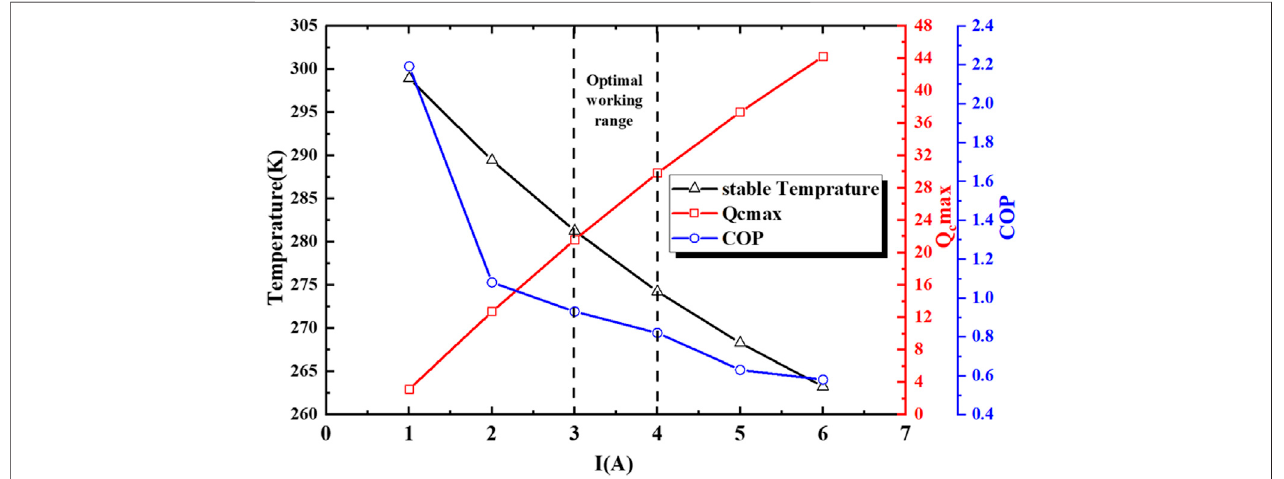
FIGURE 5 | The variation of stable temperature, maximum cooling capacity and COP of the refrigeration device with current in the compartment.